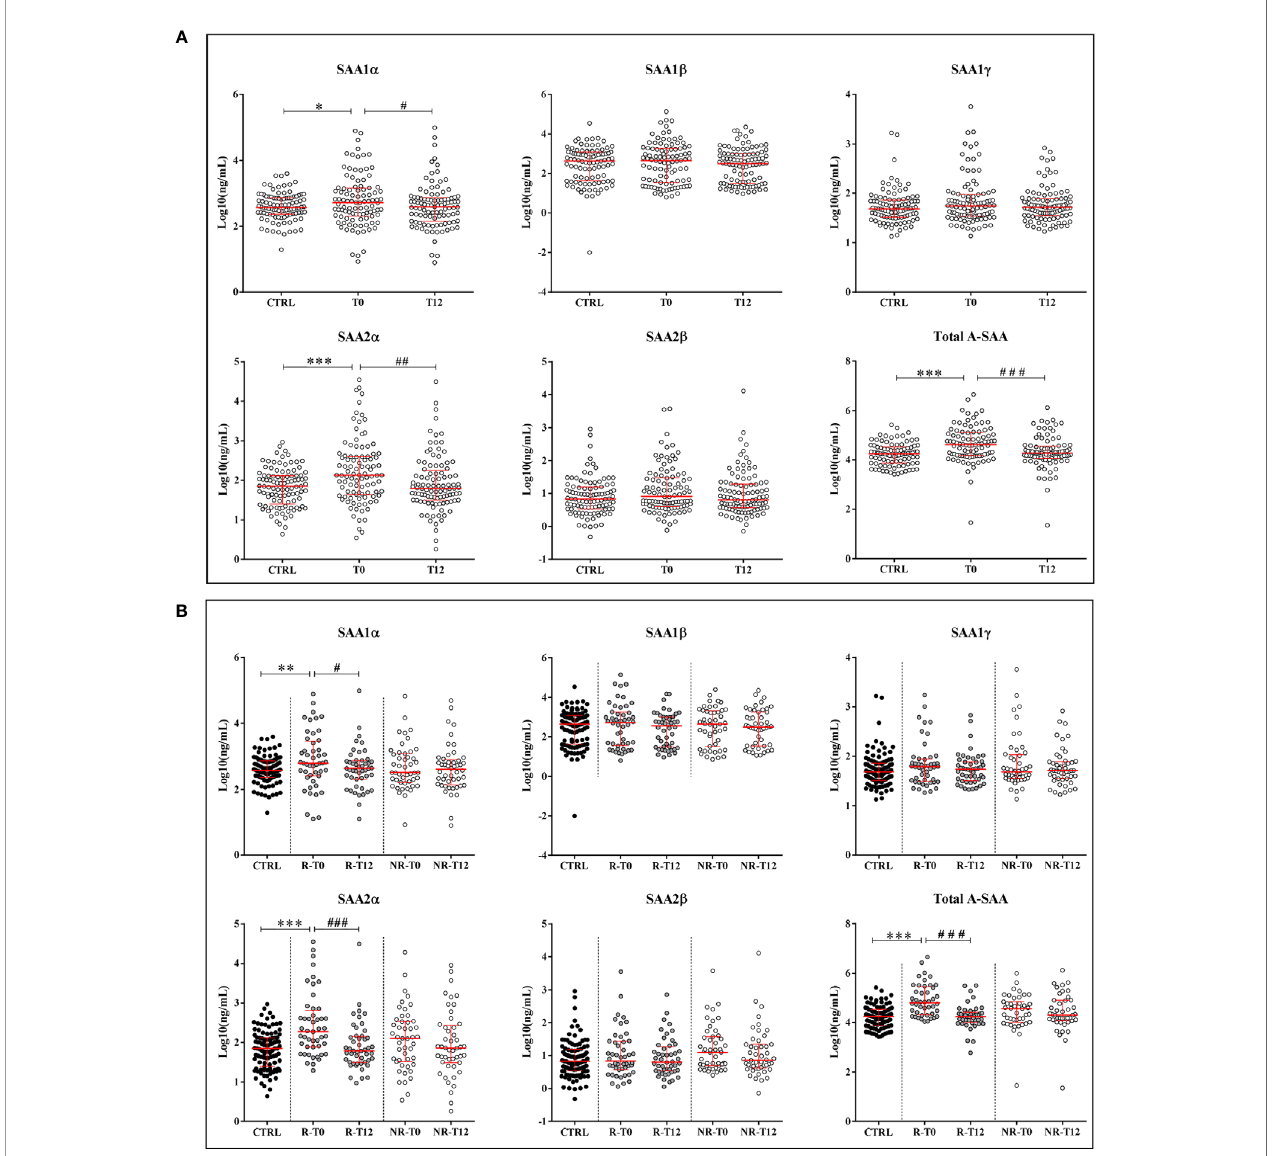
FIGURE 2 | Quanti fi cation of A-SAA by LC-MS/MS and ELISA. (A) Expression of A-SAA variants and total A-SAA in healthy volunteers (controls, CTRL) and ERA patients at time T0 and after 12 months of treatment (T12). (B) Expression of A-SAA variants and total A-SAA in ERA patients sorted in two groups: good (R) and non-responders (NR). Scatter dot plots represent the median with interquartile range. *p-value ≤ 0.05, **p-value ≤ 0.01, ***p-value ≤ 0.001 (Kolmogorov – Smirnov test); # p-value ≤ 0.05, ## p-value ≤ 0.01; ### p-value ≤ 0.001 (Wilcoxon